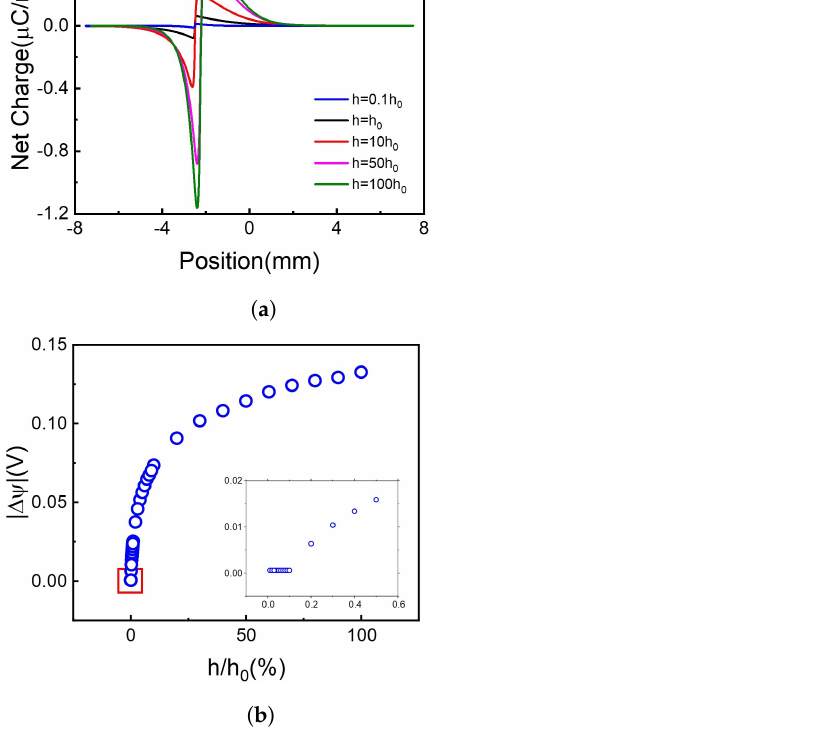
Figure 5. The net charge distribution and absolute voltage difference at different recombination coefficients. ( a ) Net charge distribution. ( b ) Voltage